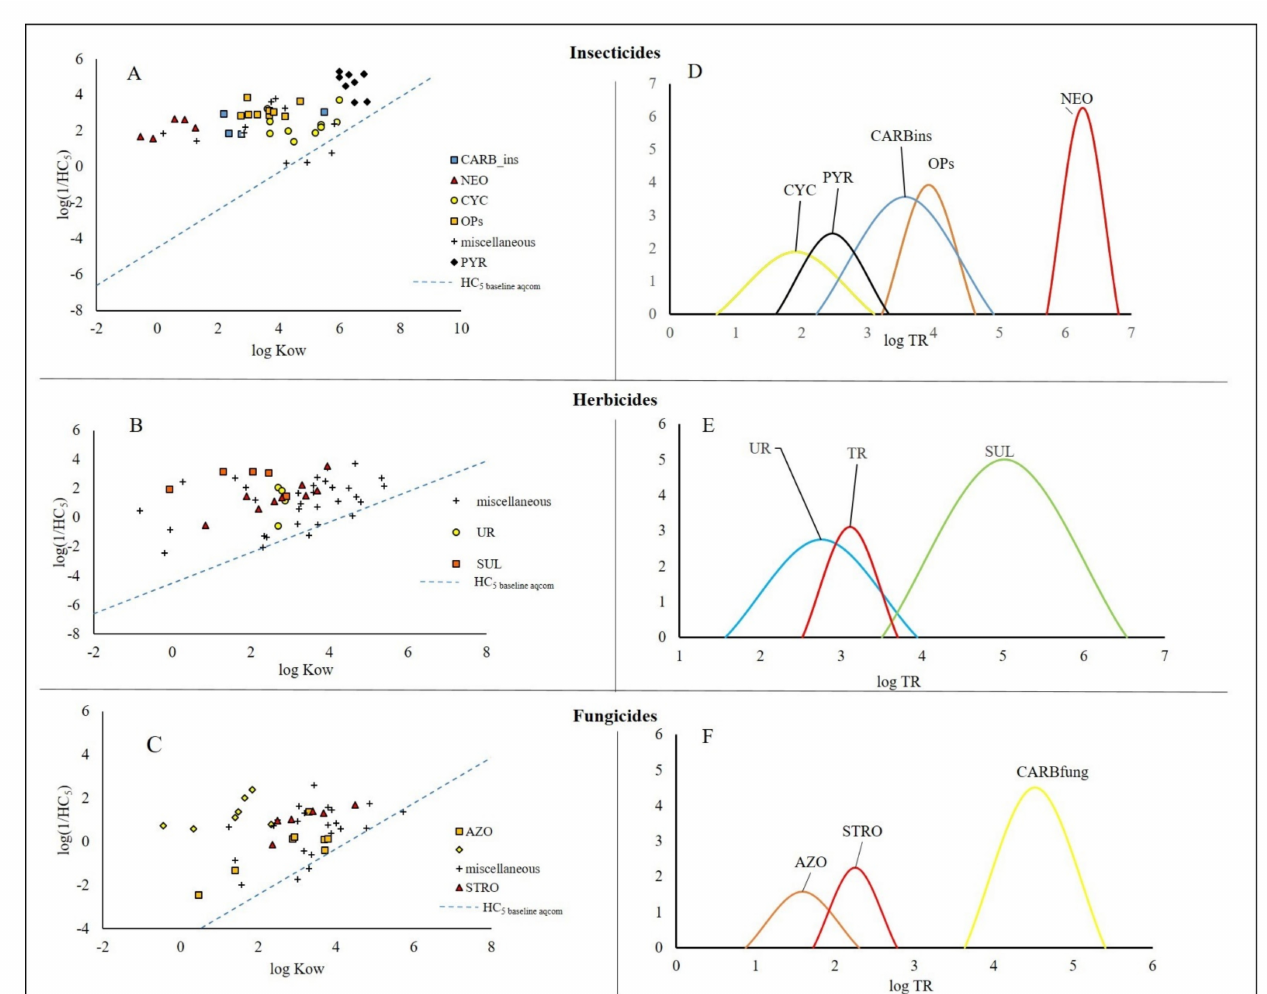
Figure 1. Distance from the baseline toxicity for aquatic communities (HC 5 baseline aqcom = dashed line calculated according to Equation (1)) and log TR distribution of different classes of pesticides: insecticides ( A , D ); herbicides ( B , E ); fungicides ( C , F